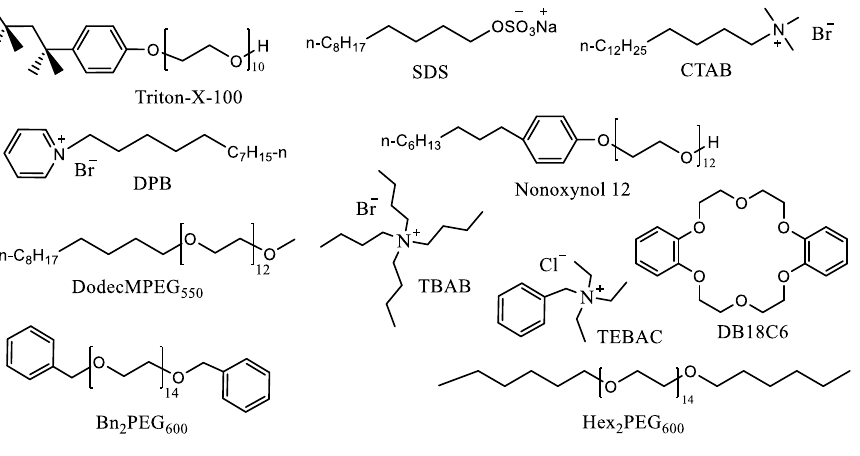
Figure 1. Representative surfactants.